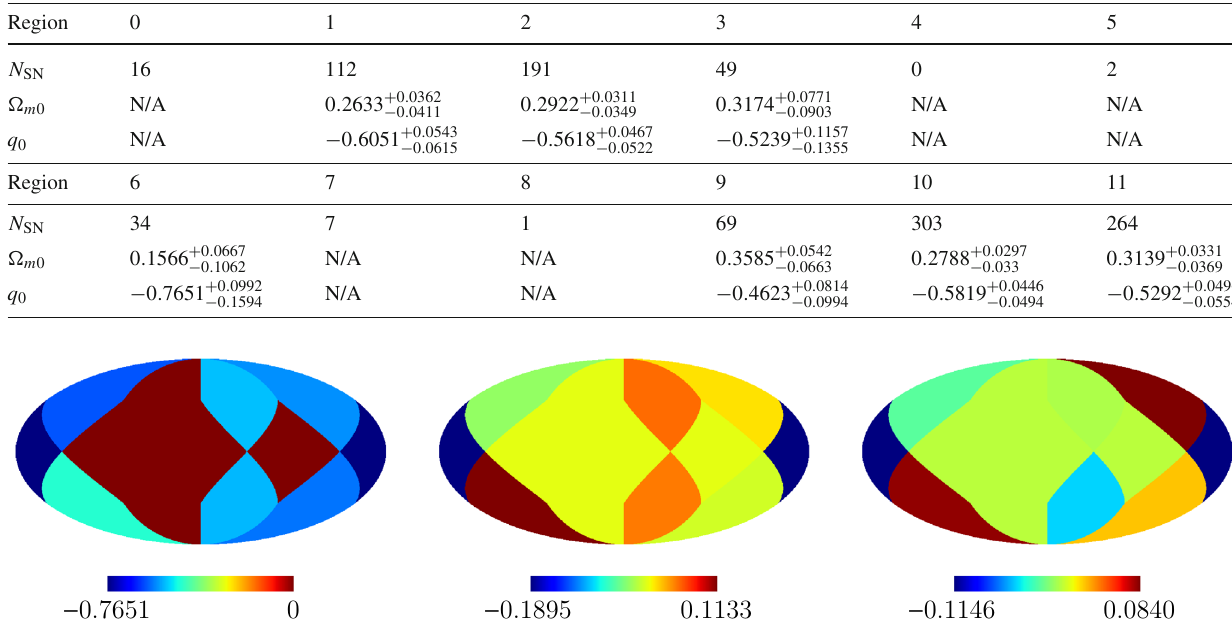
Fig. 6 Left panel: The pseudo-color map of the best-fit q 0 in the regions 1, 2, 3, 6, 9, 10, 11, while the regions 0, 4, 5, 7, 8 are masked. Middle panel: The monopole is subtracted from Left panel. Right panel: Both the monopole and the dipole are subtracted from Left panel. See the text for